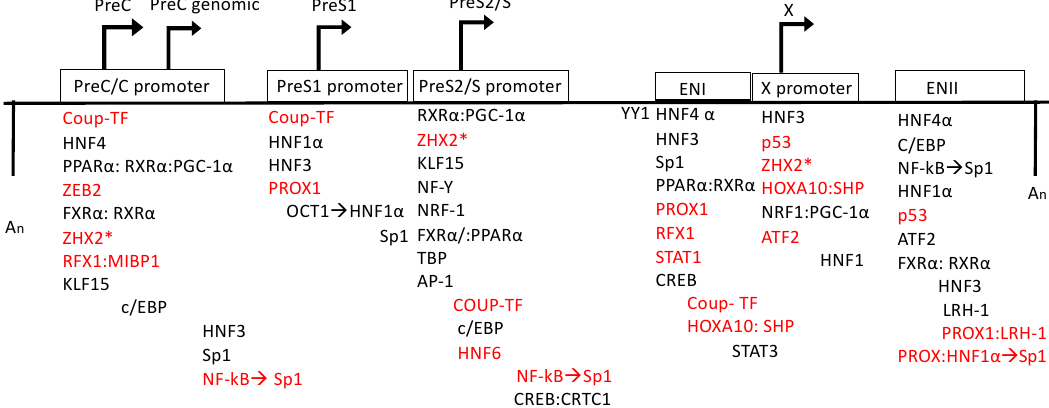
Figure 2. Relative positions of the binding sites of host transcription factors on the HBV genome. Promoter and enhancer sites are represented by the boxes and the directional arrow indicates the transcript produced. The arrows from one transcription factor to another represents an event in which one factor influences the binding activity of another. The two An sites represent the polyadenylation sites in the linearized genome schematic. Transcription factor activity has been indicated in which red represents inhibition of HBV transcription and black indicates activation of transcription. The lists of transcription factors are positioned to represent where they bind to the genome where they are